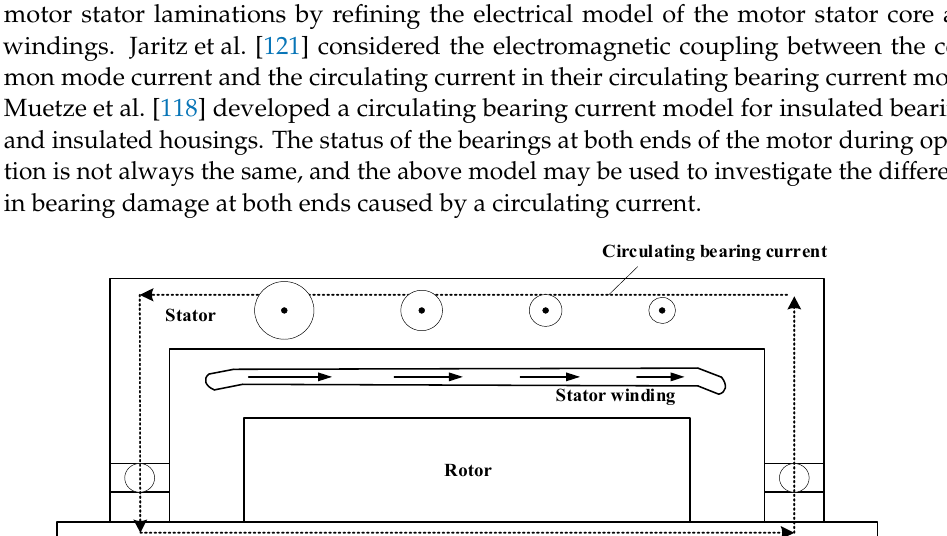
Figure 13. Circulating current due to magnetic flux asymmetry [117].